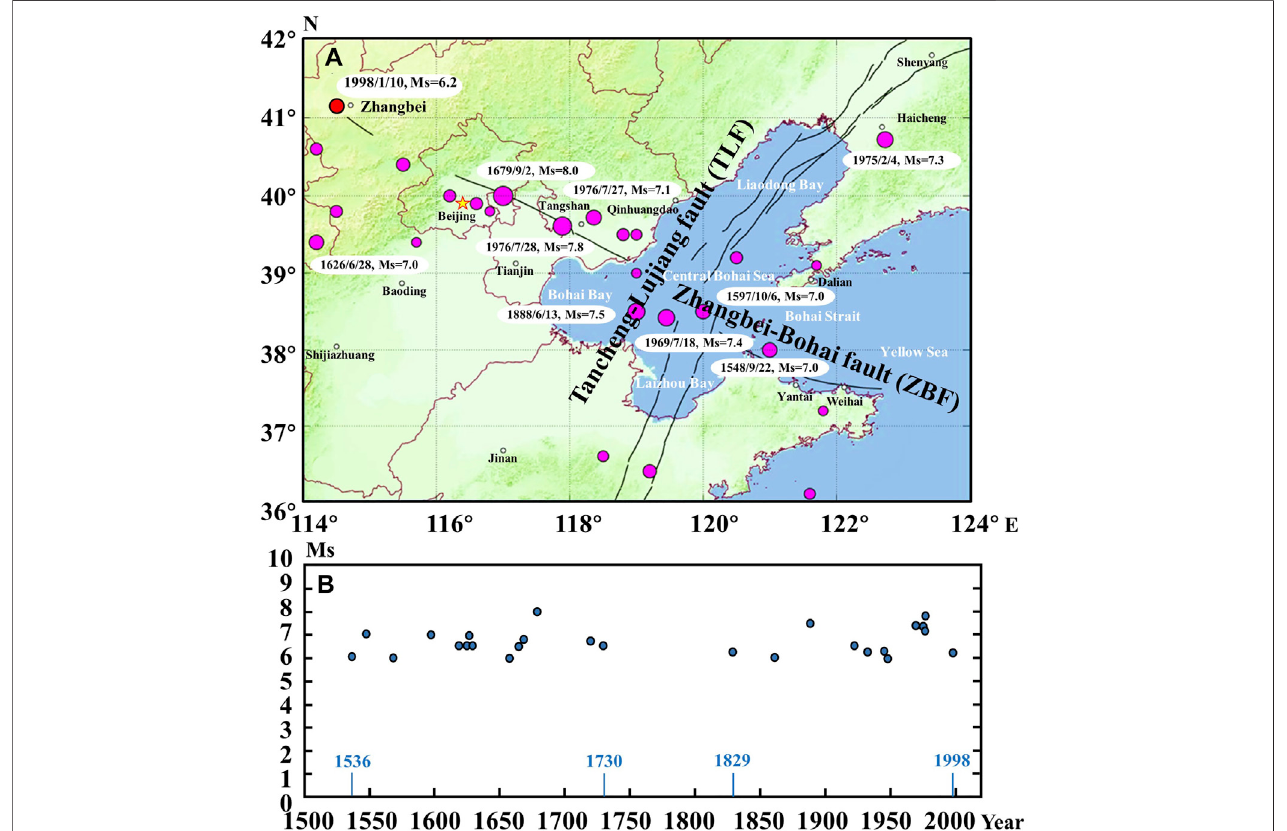
FIGURE 1 | (A) Great fault zones and epicenter distribution (B) Time series of historical earthquakes.